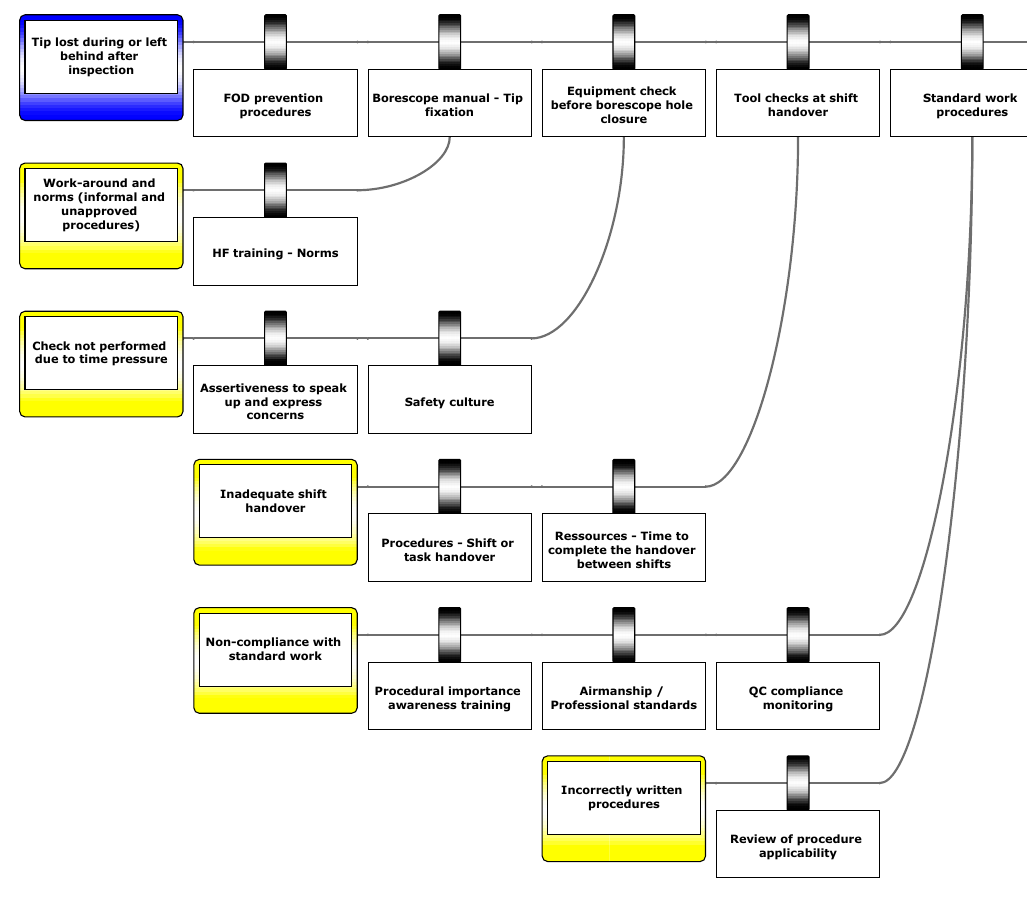
Figure A2d: “Inadequate engine or borescope knowledge” threat path.